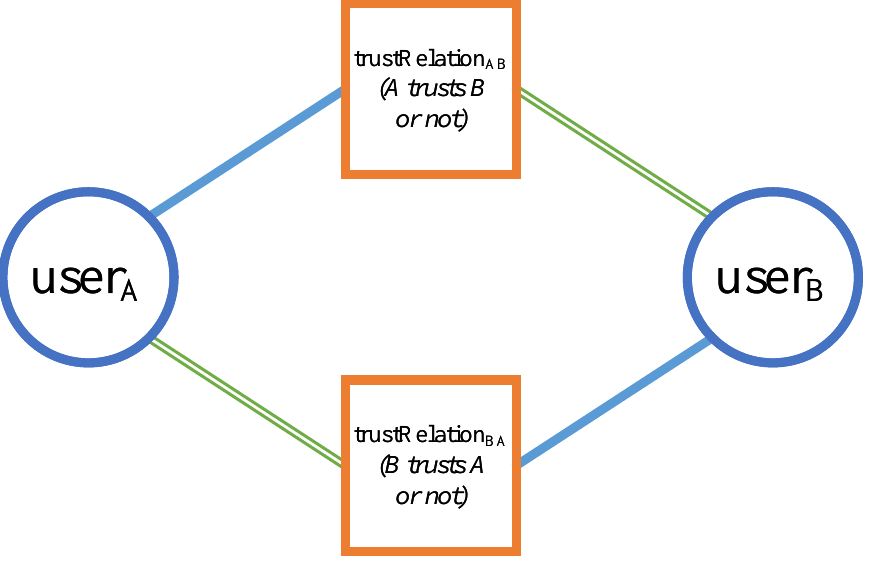
Figure 3. A demonstration of modeling two users’ mutual relationship in the proposed